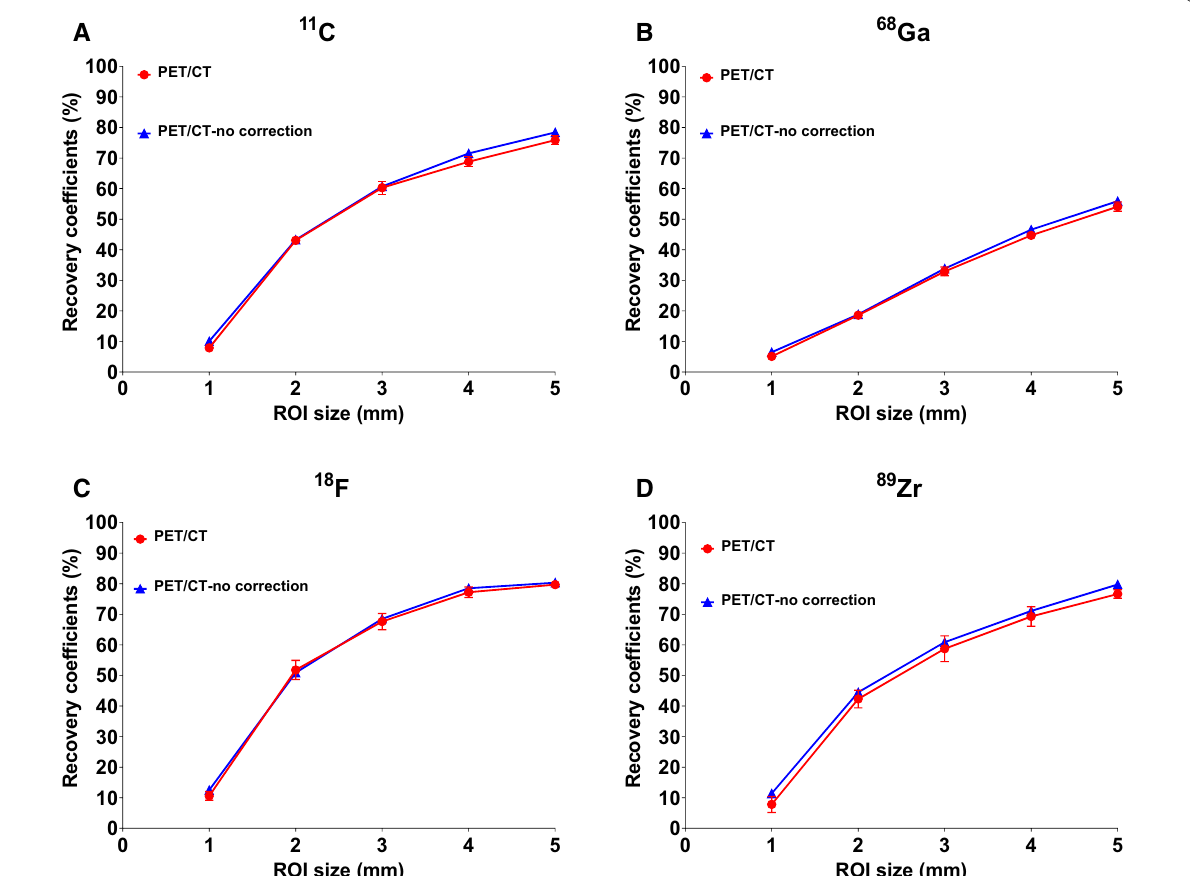
Fig. 2 NanoScan PET/CT recovery coefficients for 11 C ( A ), 68 Ga ( B ), 18 F ( C ), and 89 Zr ( D ) with and without scatter and attenuation correction (see also Additional file 1: Table S2) using the TeraTomo reconstruction